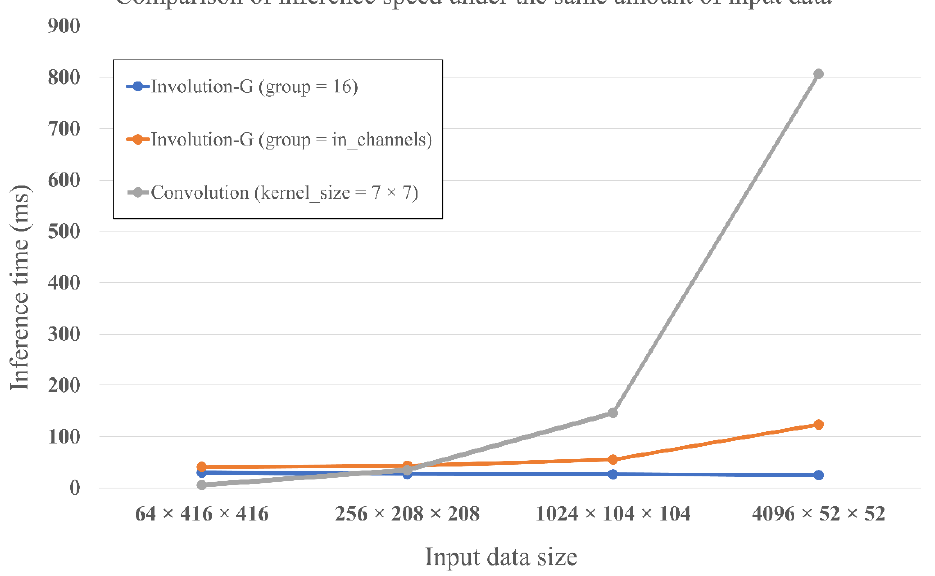
Figure 16. Inference speed of convolution and involution-G operators under the same amount of data calculation.